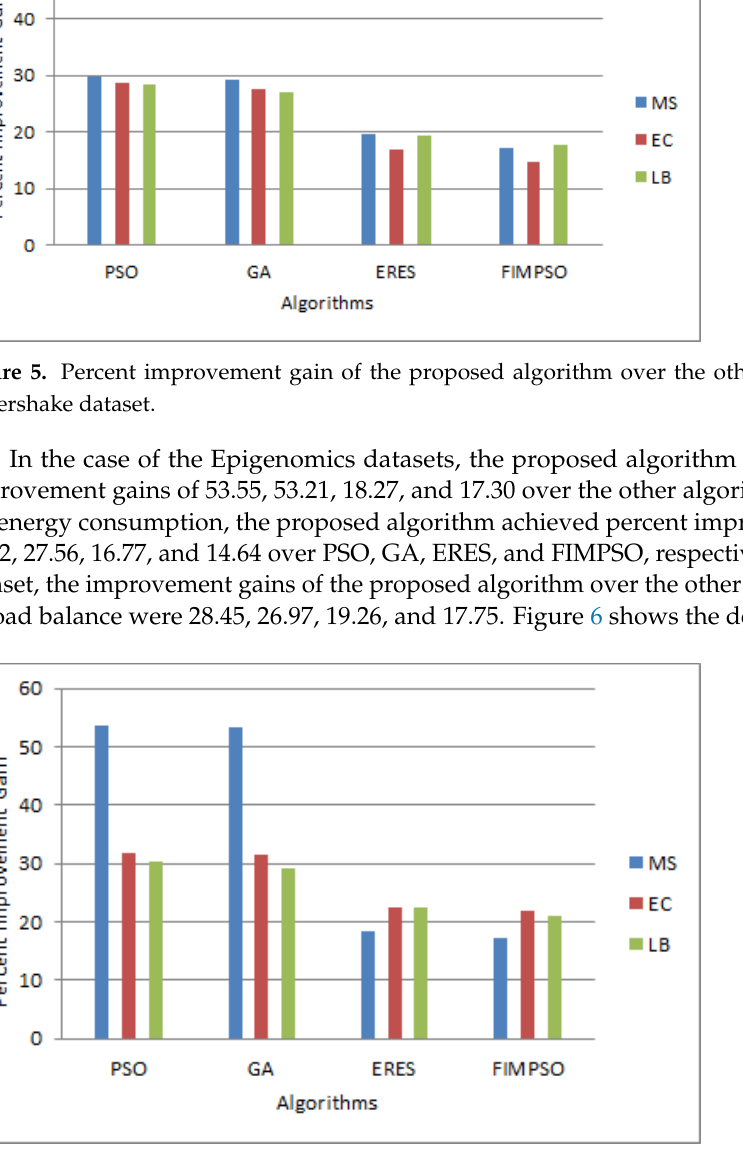
Figure 6. Percent improvement gain of the proposed algorithm over the other methods on the Epigenomics